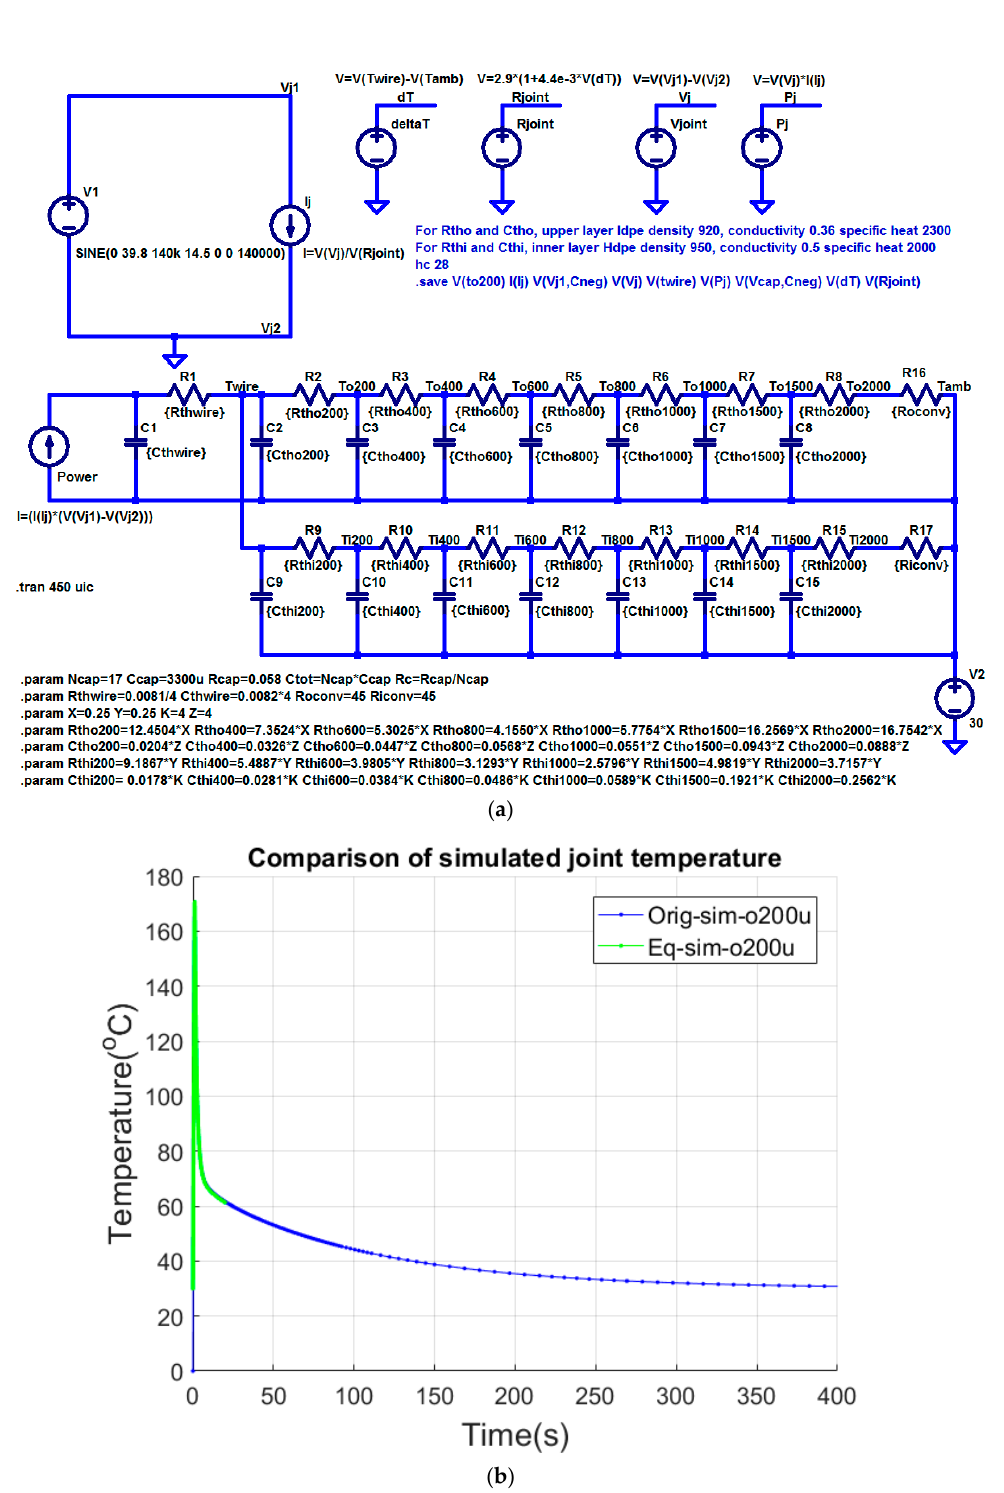
Figure 8. ( a ) Equivalent electrothermal model for faster LTspice simulation; ( b ) Comparison of the original and equivalent simulation models.